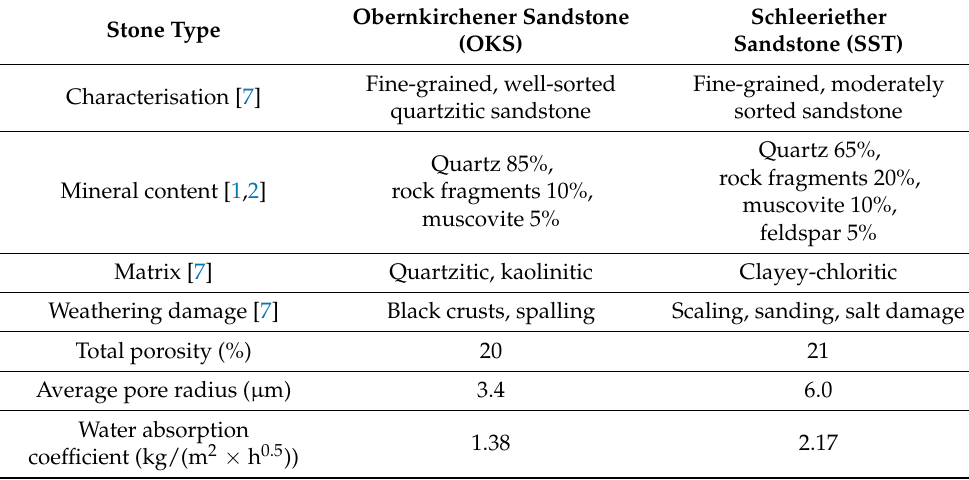
Table 1. Petrographic and petrophysical properties of Obernkirchener and Schleeriether Sandstones. The total porosity and average pore radius were measured using mercury porosimetry according to DIN ISO 15901-1 [8]. The water absorption coefficient was determined using capillary water absorption according to DIN EN 15801